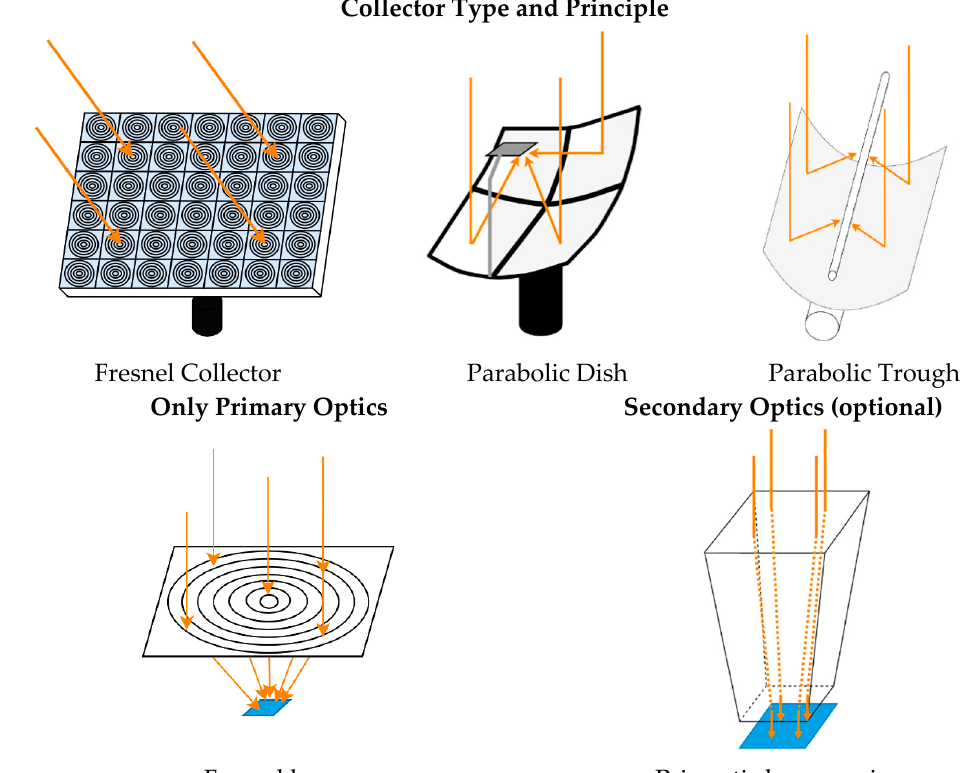
Figure 2. Concepts of concentrator photovoltaics (CPV) systems.